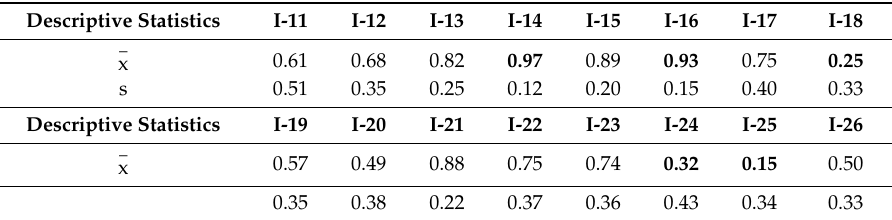
Table 5. Average scores and standard deviations for items I ‐ 11 to I ‐ 26 from dimensions V ‐ D3 and V ‐ D4. The average scores that fall above 0.9 or below 0.4 are shown in bold font.